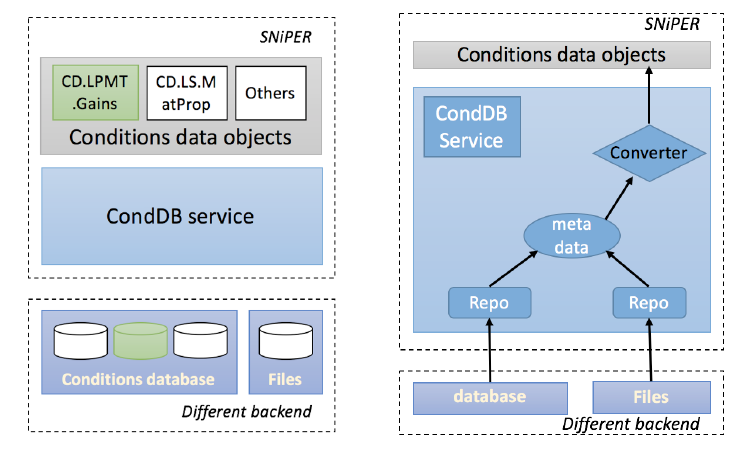
Fig. 3. The architecture of CondDB Service (left) and the conversion between transient conditions object and persistent condition data (right)